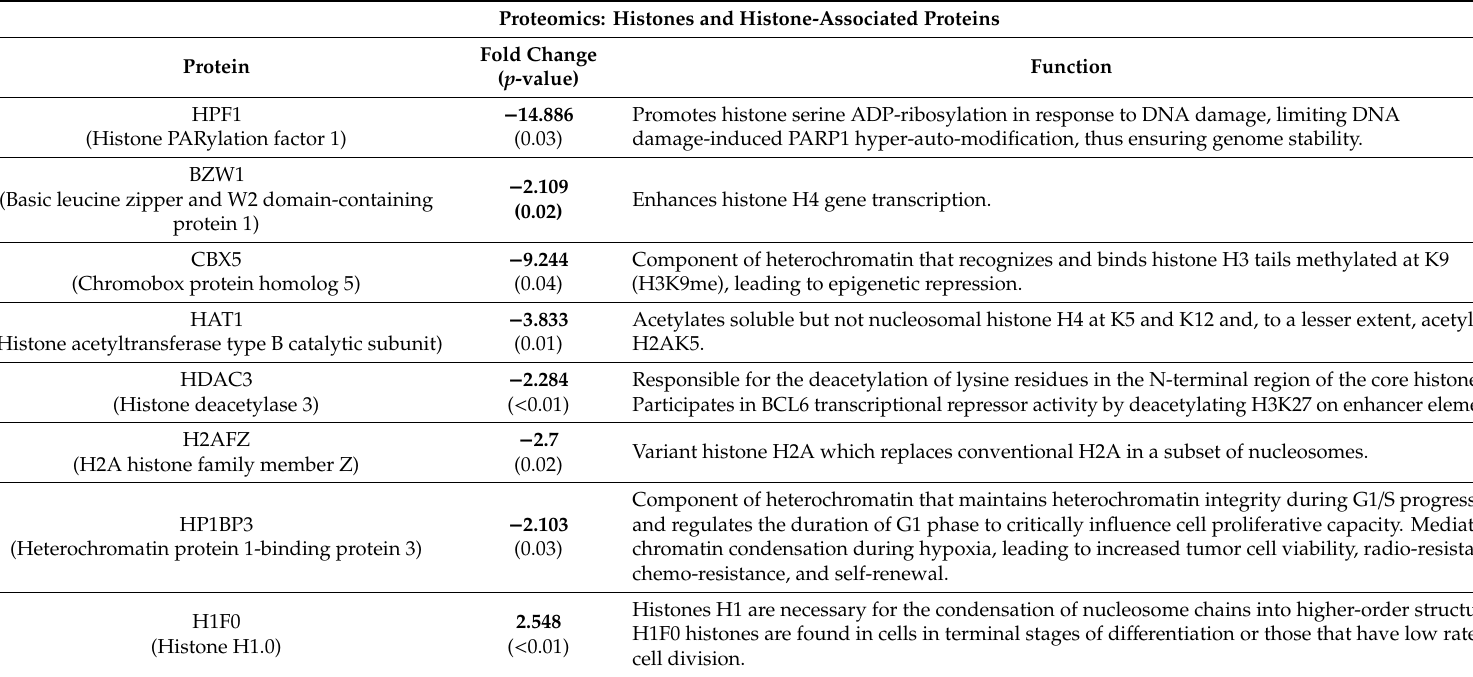
Table 3. Histones and histone-associated proteins di ff erentially expressed in si-NT-TTs and si-hVDAC1-TTs, as identified by LC-HR MS / MS. LC-HR MS / MS experiments were performed as described in the Materials and Methods section. Proteins di ff erentially expressed between si-NT-TTs and si-hVDAC1-TTs ( p -value < 0.01, fold change ≥ | 2 | ) are presented, along with the name, fold change and p -value, as well as